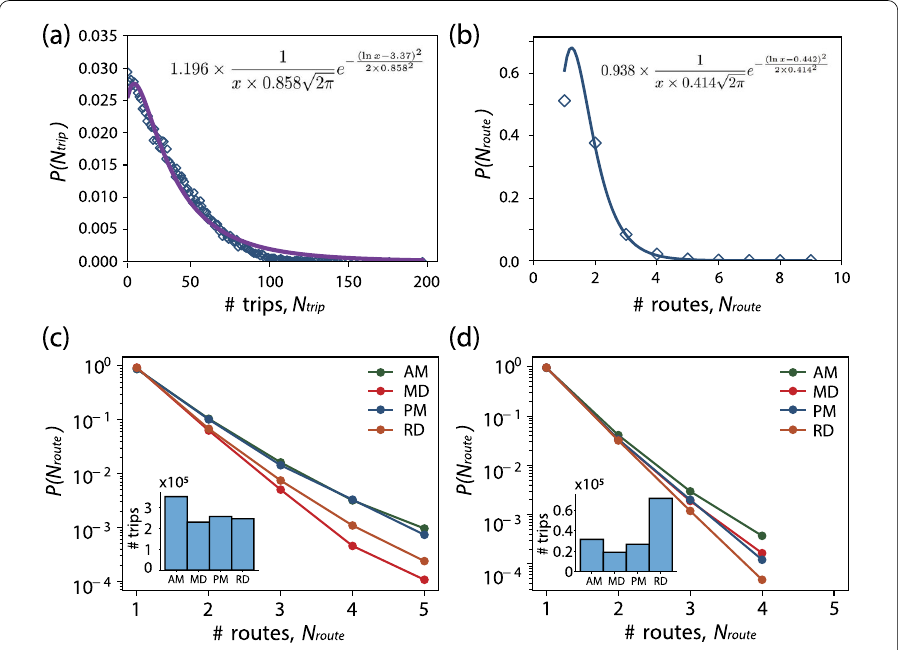
Figure 5 Route choice behavior analysis. ( a ) Distribution of number of trips, N trip , in the routine OD pairs for all active users in the LBS data. The data follows a log-normal distribution. ( b ) Distribution of number of routes, N route , in the routine OD pairs, also follows a log-normal. ( c ) Distribution of N route during different time periods, e.g., AM, MD, PM, and RD, on weekdays. The inset shows the number of trips during each time period on weekdays. ( d ) Distribution of N route during different time periods on weekends. The inset shows the number of trips during each time period on weekends